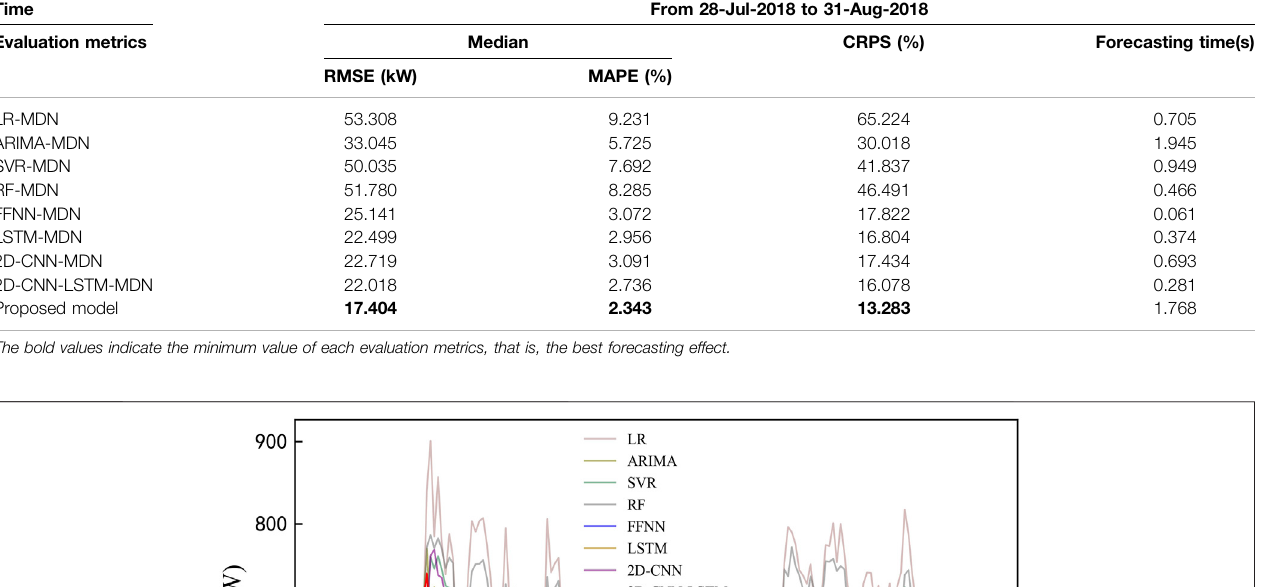
TABLE 6 | Load forecasting evaluation on the testing set. Time